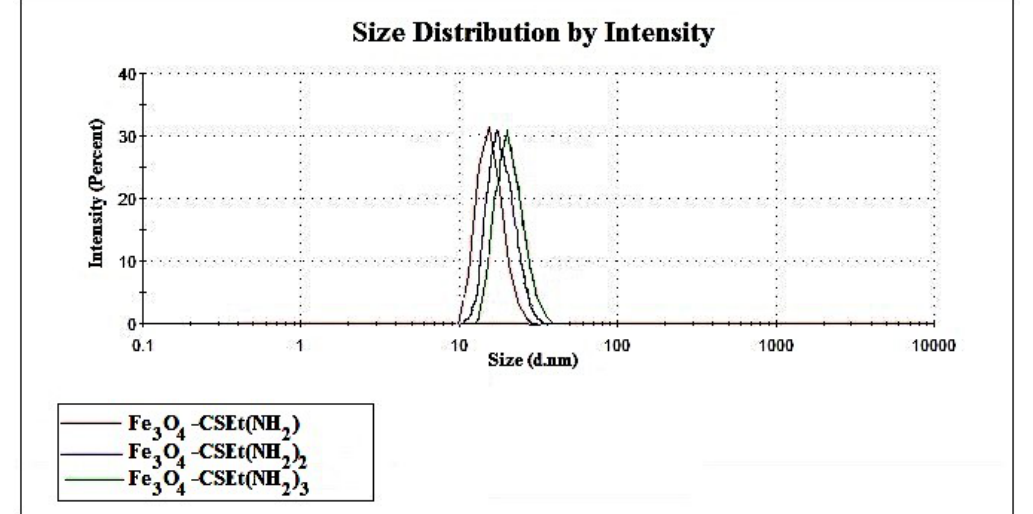
Figure 3. The distribution of the prepared nanoparticles’ size.